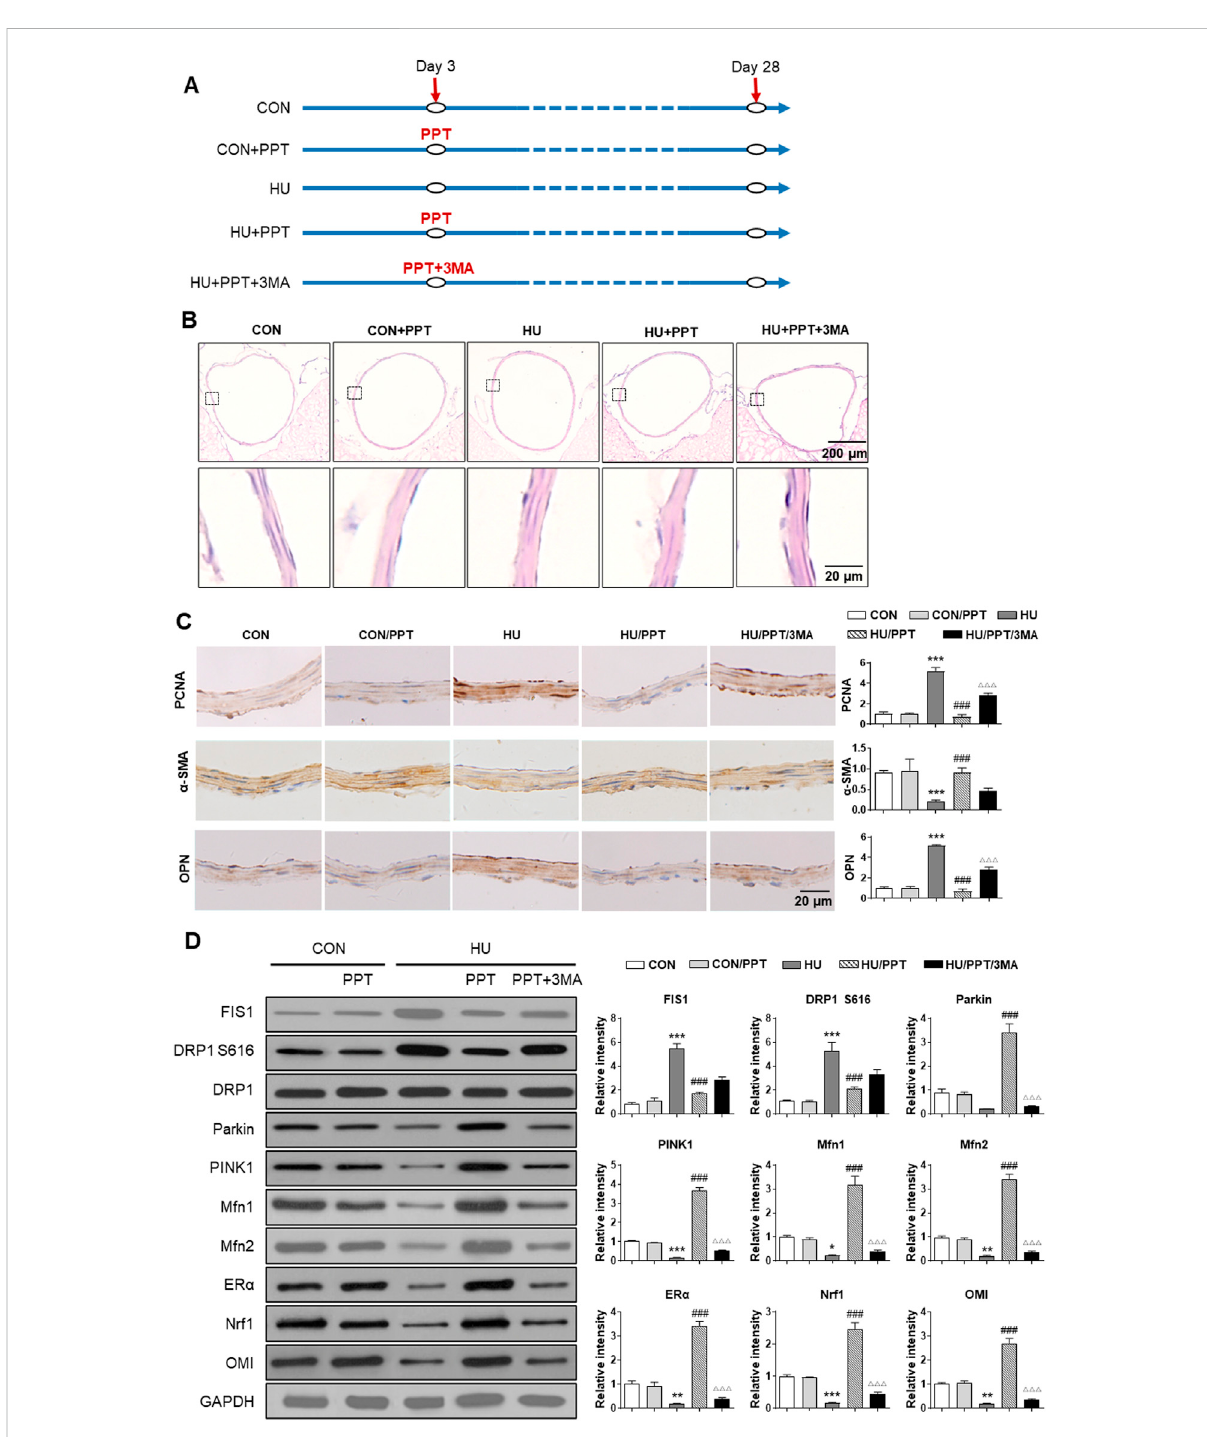
FIGURE 7 ER α regulatesphenotypicswitchingofVSMCsandcerebrovascularremodelinginsimulatedmicrogravityrats. (A) Flowchartoftheexperimental processes and schemeof animal model establishment. (B,C) Representative images showing H&E staining (B) and immunohistochemical staining of α -SMA, OPN and PCNA (C) of rat basilar arteries under HU or control. (D) Western blot analysis of Fis1, p-Drp1 S616, Drp1, Parkin, Pink1, Mfn1/2, ER α , Nrf1, and OMI protein in rat cerebral VSMCs under HU or control. PPT was used as ER α agonist and 3 MA was used as mitophagy inhibitor. * p < 0.05, ** p < 0.01 and *** p < 0.001 vs. control, ### p < 0.001 vs. HU, ΔΔΔ p < 0.001 vs. HU +